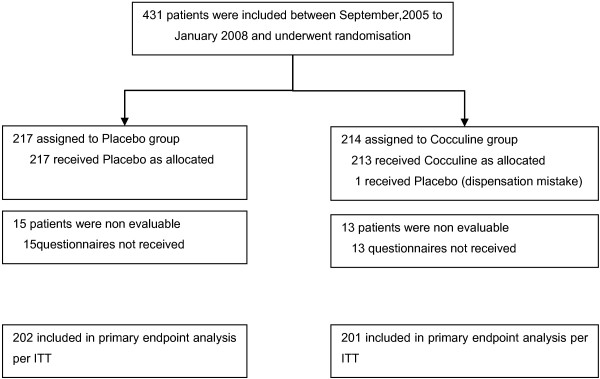
CONSORT diagram.